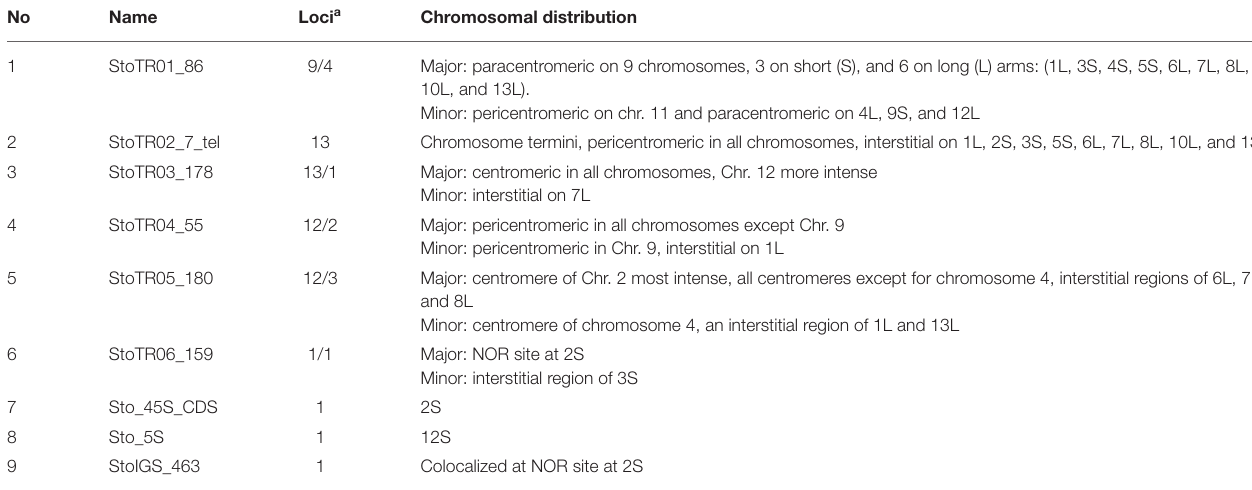
TABLE 3 | Chromosomal distribution of the DNA repeats identified in the S. tora